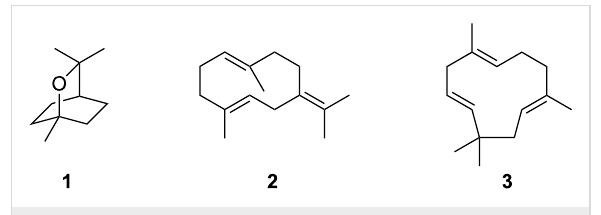
Figure 1: Selection of achiral terpenes.